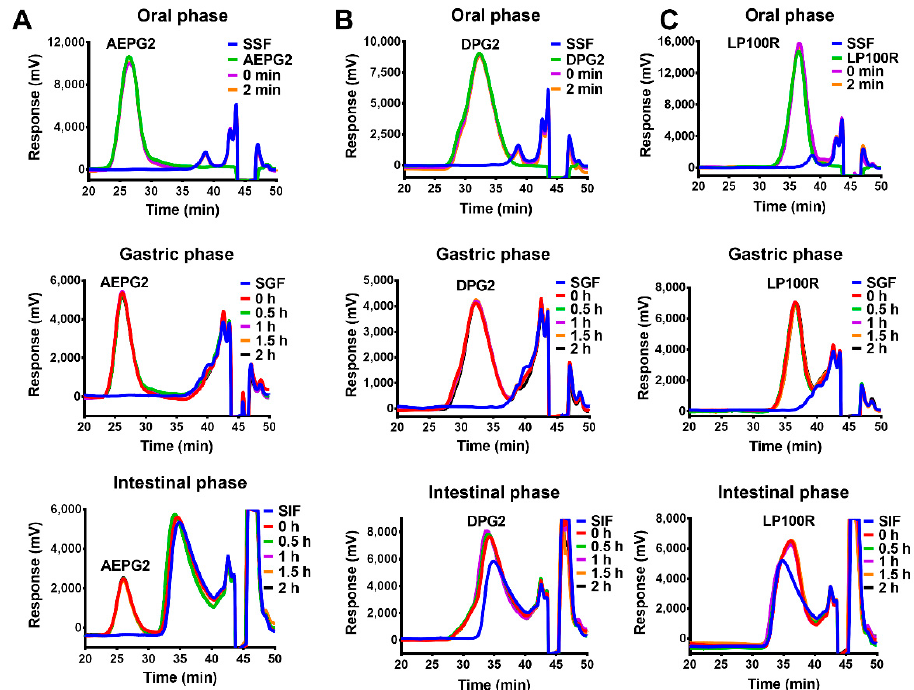
Figure 2. Changes in molecular weights of PGPs in the digestive process: ( A ) AEPG2; ( B ) DPG2; ( C ) LP100R.